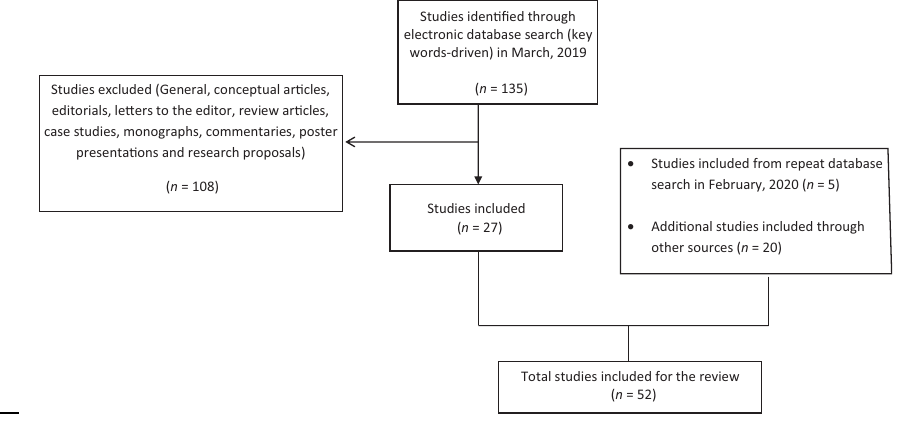
Figure 1. Study selection flow